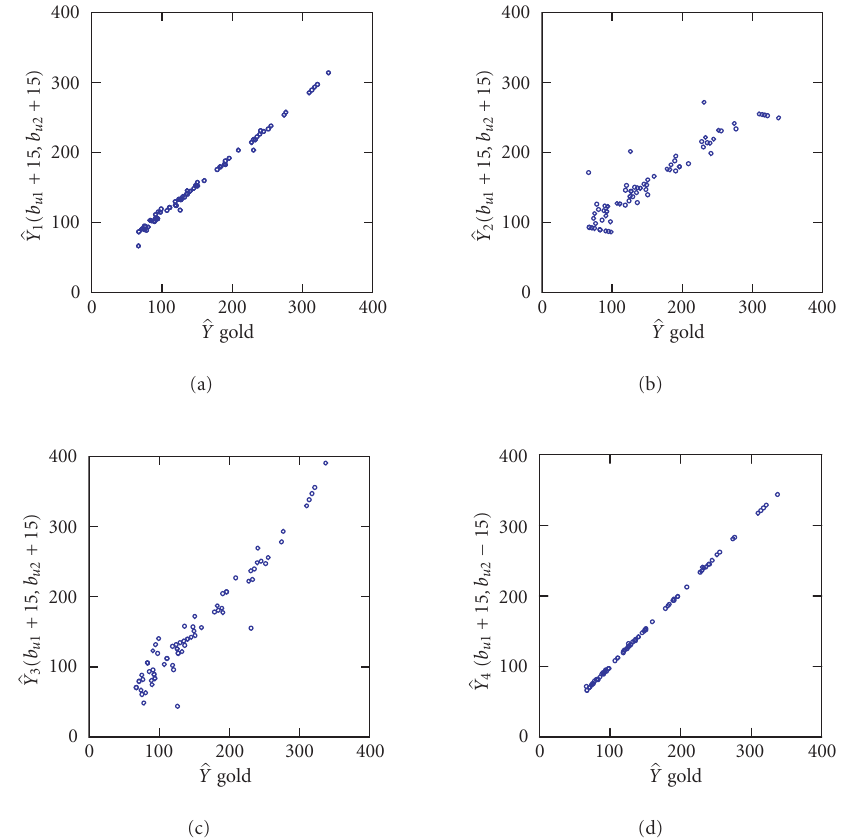
Figure 4. Univariable synthesis method—e ff ect of perturbing both b u 1 and b u 2 on correlations between the predicted values for the perturbed and unperturbed models. The x -axes represent the estimated Y of the unperturbed model ( (cid:14) Y gold); the y -axes represent the estimated Y of the perturbed models. The y -axes labels indicate the perturbation. For example, for Y 1 , both b u 1 and b u 2 were perturbed by adding 15. The estimating equation was then computed and (cid:14) Y 1 was